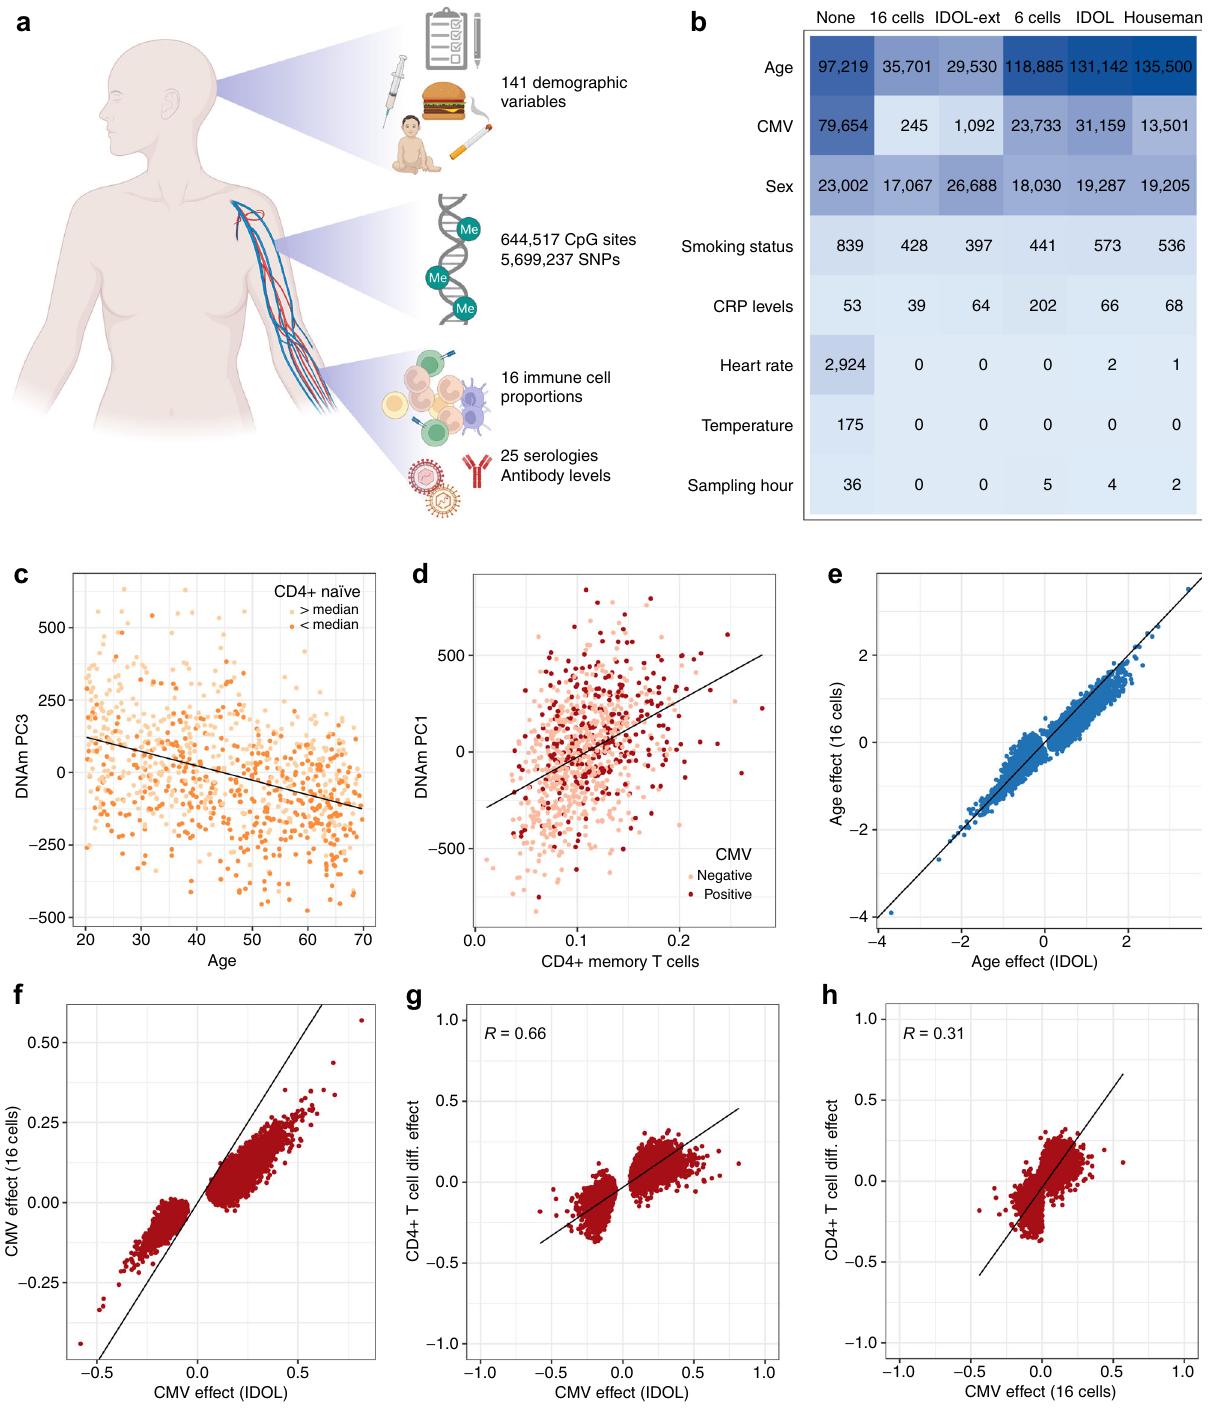
bodytemperature( n =175),C-reactiveprotein(CRP)levels( n = 53),the hour of blood draw ( n =36) and traits related to lipid metabolism ( n =3; Fig. 1b and Supplementary Data 1). Accordingly, the fi rst PCs of DNA methylation are most strongly associated with CMV (PC1: P =8.3× 10 − 13 ; PC2: P =7.8 ×10 − 10 ), age (PC3: P = 5.7×10 − 29 ) and sex (PC4: P =2.2× 10 − 5 ), when not considering immune cell fractions (Fig. 1c, d and Supplementary Fig. 1i, j). When adjusting on blood cell composition, factors that have signi fi cant direct effects on DNA methylation include age ( n = 35,701; 5.5%), sex ( n =17,067; 2.6%), smoking ( n =428; 0.07%), CMV serostatus ( n =245; 0.04%), CRP levels ( n =39) and lipid metabolism-related traits ( n =3; Fig.